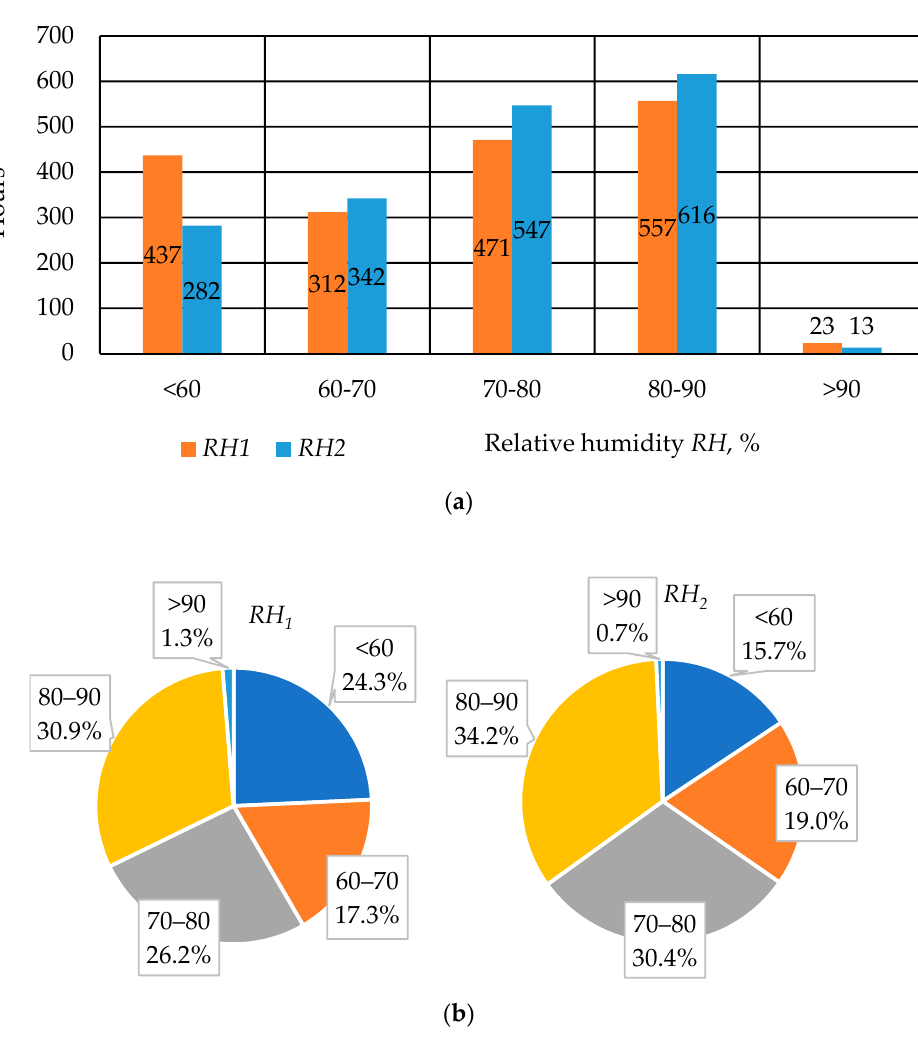
Figure 6. Relative humidity distribution by hours ( a ) and by percentage ( b ). The average value of relative humidity increased from 70.7% for the air coming from outside, to 73.1% for the air inside the cowshed. In addition, the relative humidity values greater than 80% increased by 2.7% inside the cowshed. The values of relative humidity less than 60%, in comparison, decreased by 8.3%. Therefore, we can conclude that the operation of a cooling system leads to an increase in relative humidity, although this growth is